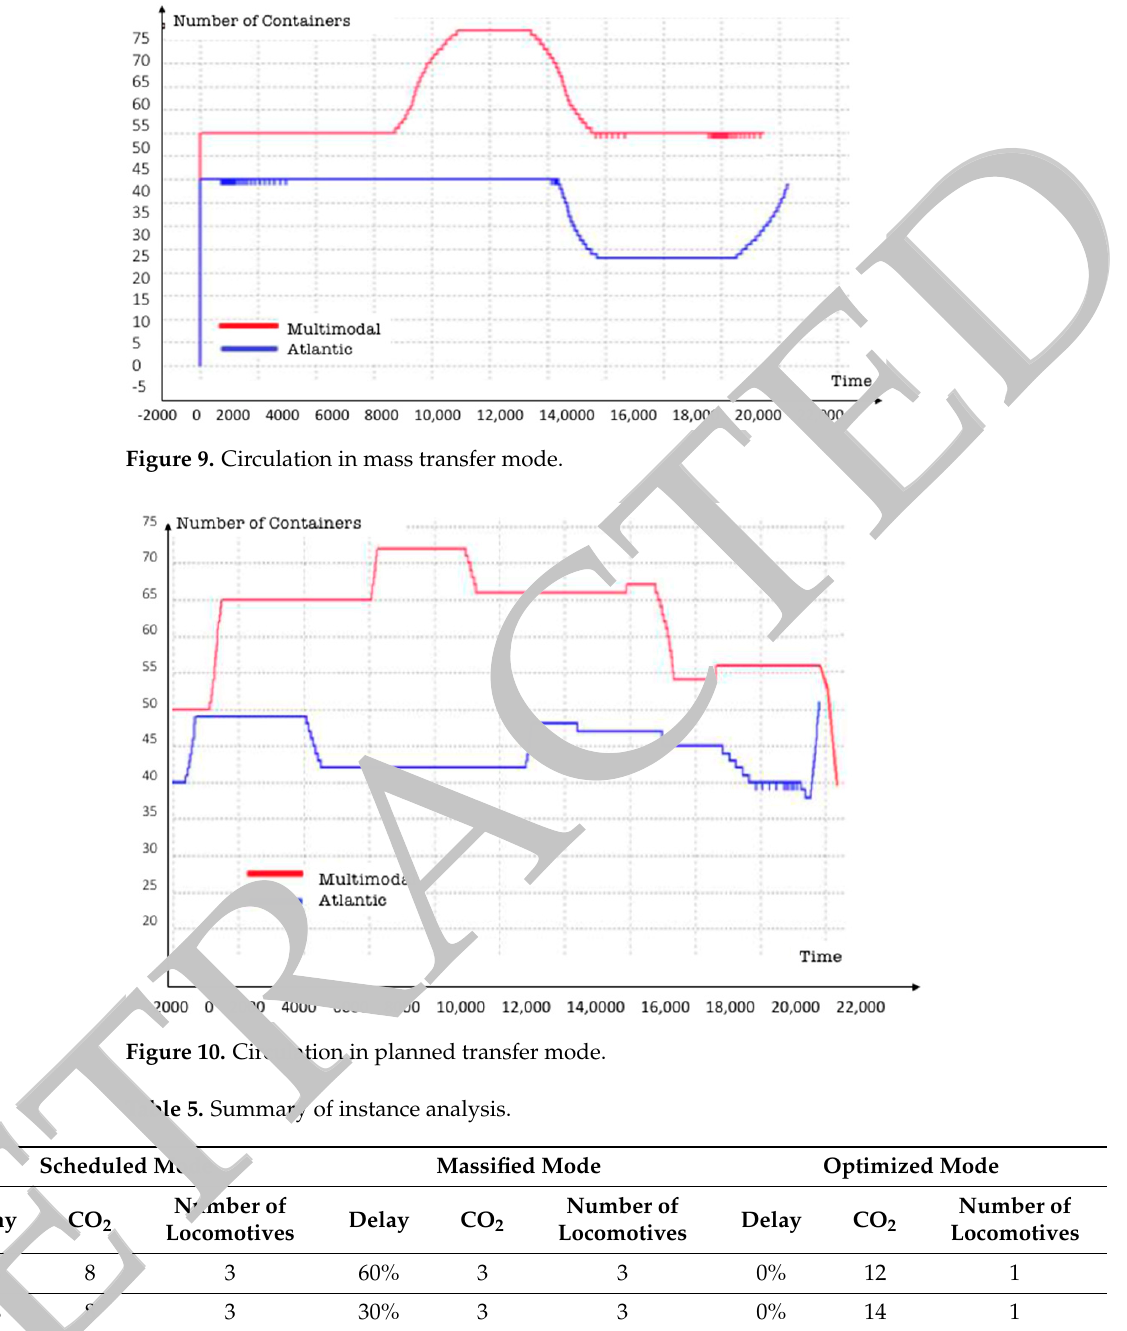
Figure 8. Circulation in optimized transfer mode.